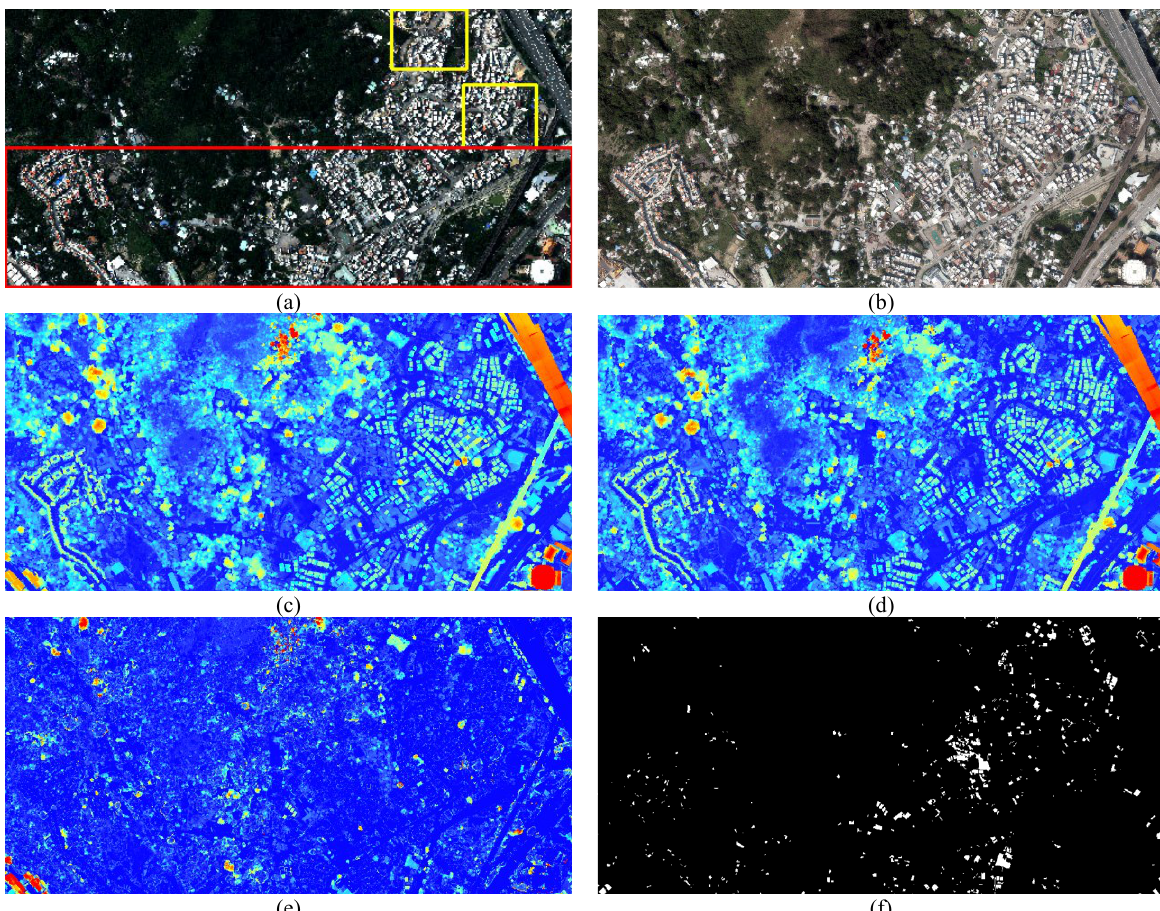
Figure 3. The experimental area. (a) The first period RS image. (b) The second period RS image. (c) The first period DSM. (d) The second period DSM. (e) The difference DSM. (f) Ground